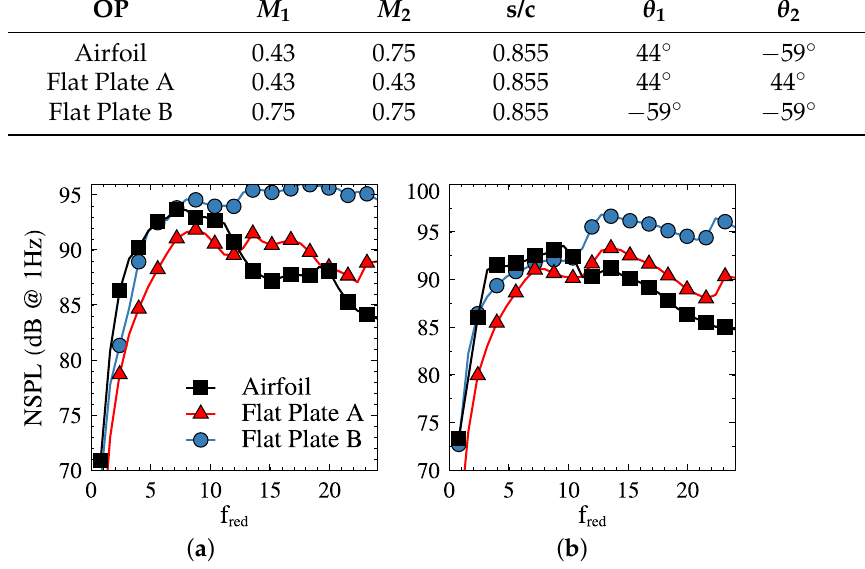
Figure 3. Non dimensional sound pressure level (NSPL) comparison between actual airfoil and equivalent flat plates, A and B. ( a ): inlet; ( b ): outlet. Note that the dimensionless pressure and reduced frequency of the flat plate B have been computed using the inlet properties for